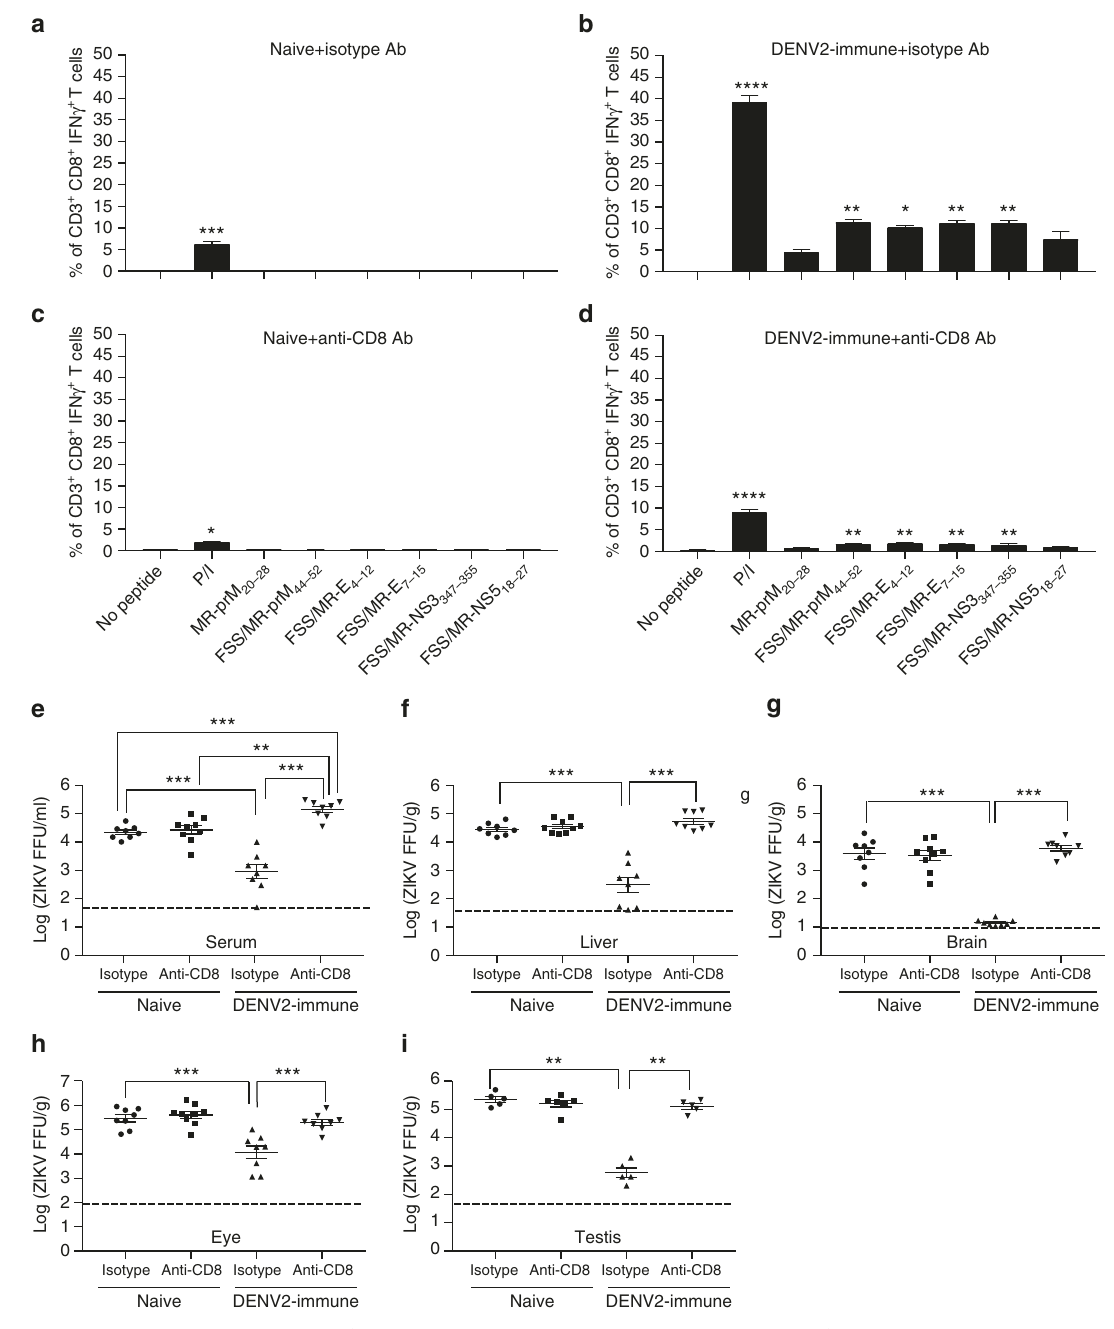
Fig. 1 ZIKV tissue burden in DENV-immune Ifnar1 − / − mice in the presence or absence of CD8 + T cells. Ifnar1 − / − mice were immunized intraperitoneally with DENV2 (2 × 10 2 FFU) for 28 days. Naive and DENV2-immune mice were injected intraperitoneally with isotype control Ab and anti-mouse CD8 Ab at 3 days and 1 day before ZIKV challenge. Three days post ZIKV challenge, peptide-speci fi c CD3 + CD8 + IFN γ + T cells ( a – d ; a , c naive mice; b , d DENV2- immune mice) and infectious ZIKV levels in sera ( e ) and indicated organs ( f – i ) were detected using ICS assay and FFA, respectively. Data were pooled from two independent experiments with n = 3 – 5 mice per group per experiment and expressed as mean ± SEM. * p < 0.05, ** p < 0.01, *** p < 0.001, **** p < 0.0001. A Kruskal – Wallis one-way ANOVA was used for a – d while two-tailed Mann – Whitney test was used for e – i . Supplementary Tables 1 and 2 provide exact values of n and T cells (Fig. 3a). In serum and all organs, transfer of 1 × 10 7 against ZIKV infection by reducing virus levels in multiple DENV2-exposed CD8 + T cells led to signi fi cant reduction in infectious ZIKV levels (Fig. 3b). Consistent with these results with Ifnar1 − / − mice, adoptive transfer of DENV-exposed CD8 + T cells isolated from WT mice also resulted in a signi fi cant decrease in ZIKV levels in the serum and liver of WT recipients (Fig. 4a, b). Thus, DENV-reactive CD8 + T cells can mediate cross-protection